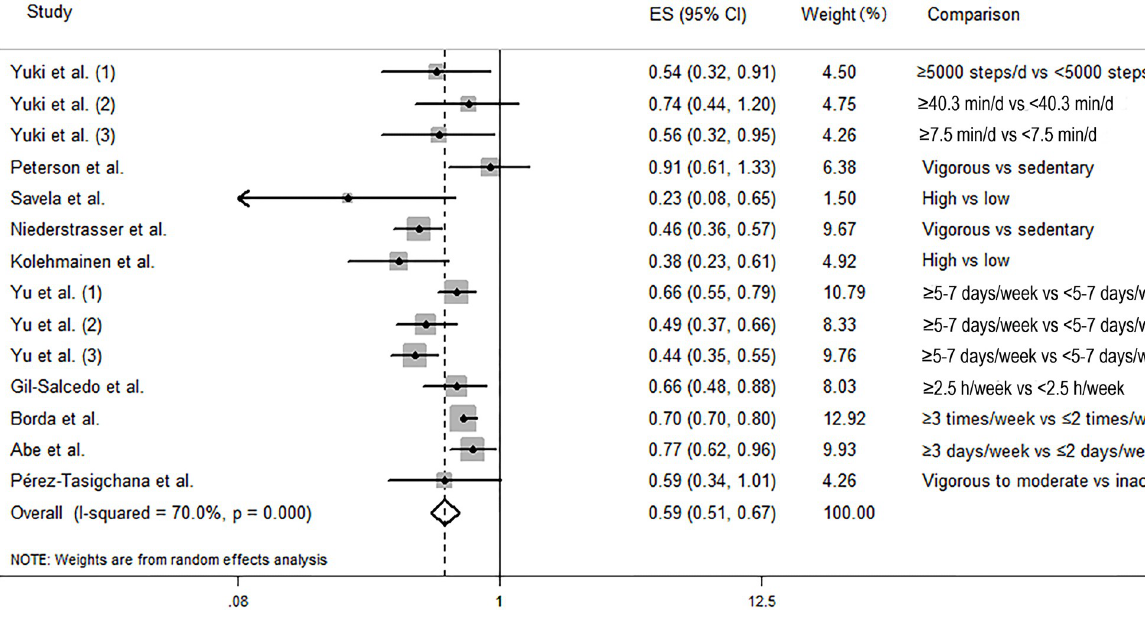
Fig 2. Forest plot of association between physical activity and the risk of